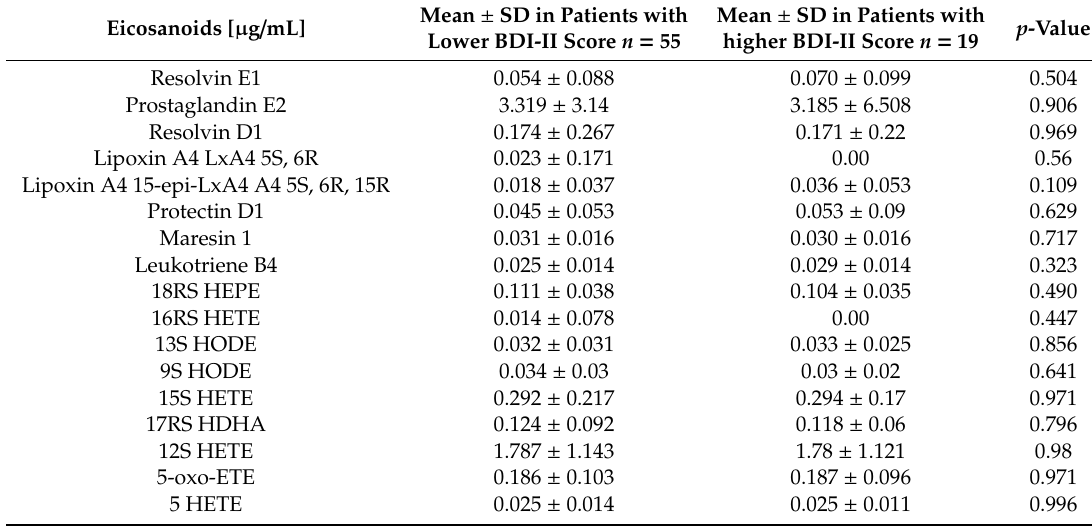
Table 6. The comparison of eicosanoids level between patients with low ( < 14) vs. higher ( > 13) BDI-II score. Mean ± SD in Patients with Eicosanoids [ µ g / mL] Lower BDI-II Score n = 55